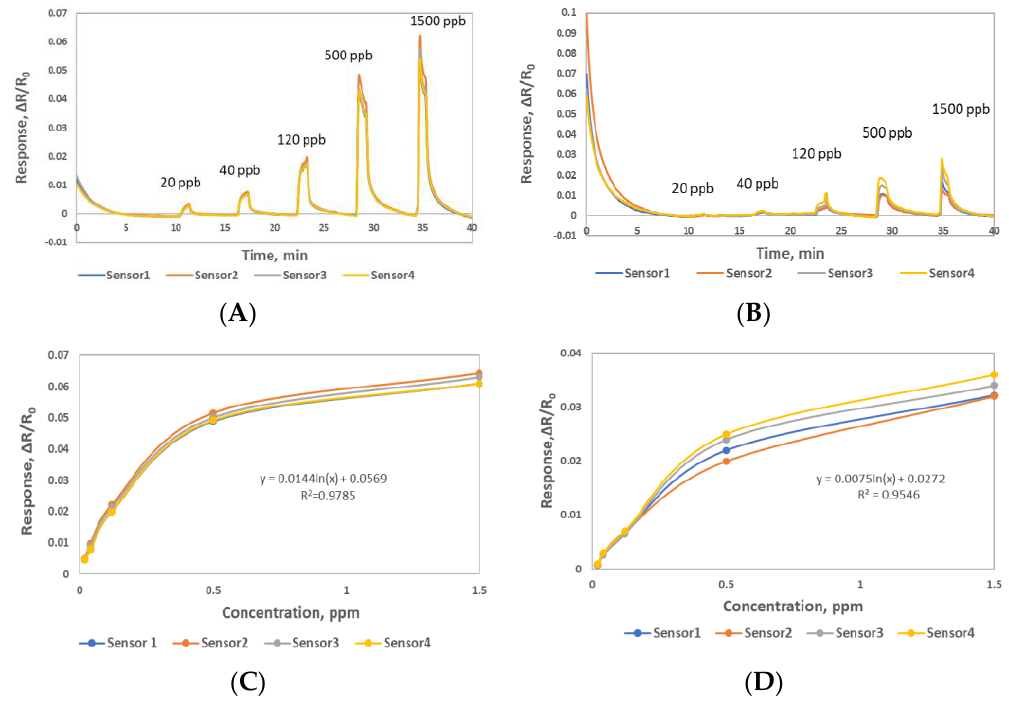
Figure 4. Sensor responses (ΔR/R 0 ) to 0.02, 0.04, 0.12, 0.5, 1.5 ppm NO gas at 0% RH (A) Material 1 sensors ( B ) Material 2 sensors ( C ) calibration curves of four sensors made from Material 1 ( D ) calibration curves of four sensors made from Material 2.